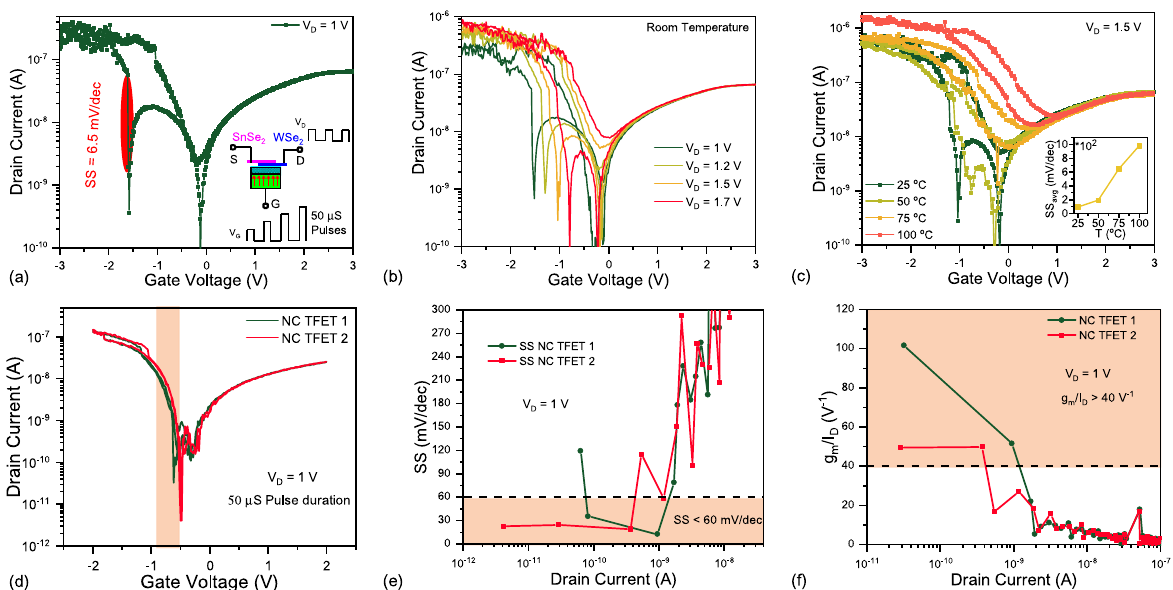
Fig. 5 Pulsed measurements of the hysteretic and hysteresis-free NC 2D/2D TFETs. a I d − V g curve of the NC-TFET, showing a steep SS of 6.5 mV per decade over almost two decades of current. The employed pulsed measurement technique is schematically demonstrated in the inset fi gure. b Transfer characteristic of the NC-TFET at multiple drain voltages, showing a clear degradation of SS by increasing V the same device in different temperatures ( V d = 1.5 V). The SS of the device increases at elevated temperatures. d Transfer characteristic of two different non-hysteretic NC-TFETs, and e the corresponding subthreshold swings. A sub-thermionic SS, down to 15 mV per decade over two decades of current, is reported at room temperature. f Transconductance ef fi ciency of both devices, showing a peak of 50 V − 1 and 100 V − 1 . The peak transconductance ef fi ciency exceeds the fundamental 40 V − 1 limit of MOSFET